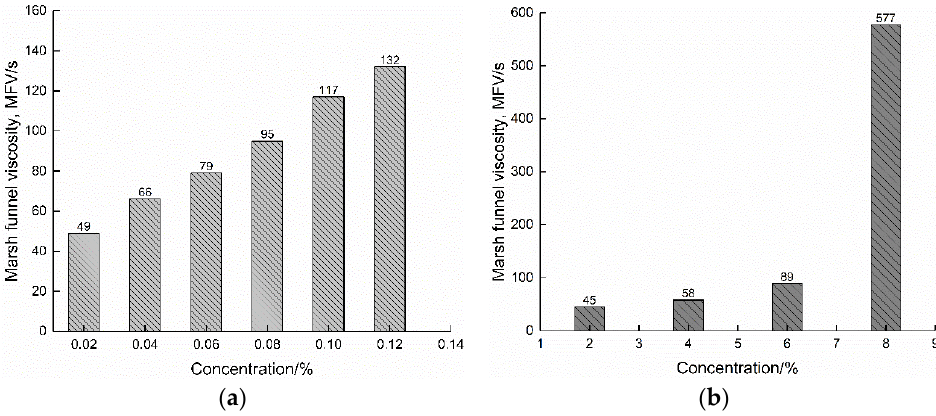
Figure 2. Marsh funnel viscosity of two fluids: ( a ) polymer fluid; ( b ) bentonite fluid.